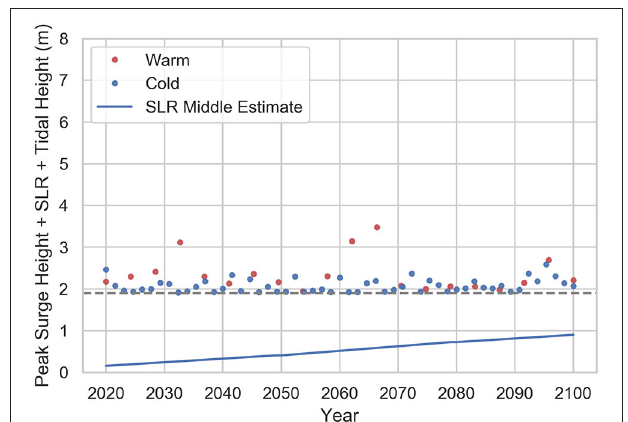
FIGURE 6 | An example of one simulation of randomly generated storms expressed through their corresponding peak water levels (peak storm surge + SLR + tidal height) over the 80-year period considered (2020–2100). The blue dots depict peak storm surges in cold season. The red dots depict peak storm surges in warm season. Middle SLR estimate (Horton et al., 2015; Gornitz et al., 2019 ) is considered. SLR is denoted by the continuous sloped blue line. The dashed horizontal gray line indicates the 1.9 m threshold, below which there is no flooding observed in Lower Manhattan.